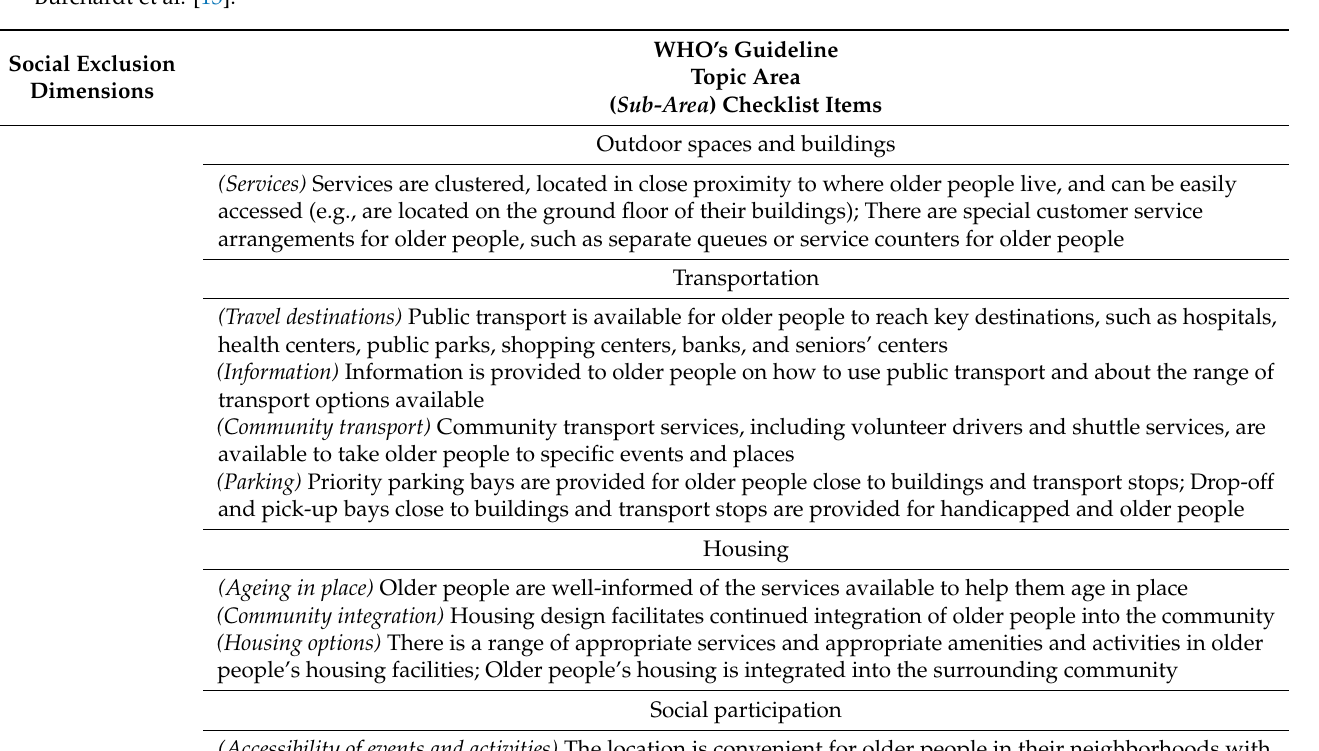
Table 1. Analysis of WHO’s (2007) Guideline for Global Age-Friendly Cities using the framework of social exclusion by Burchardt et al.